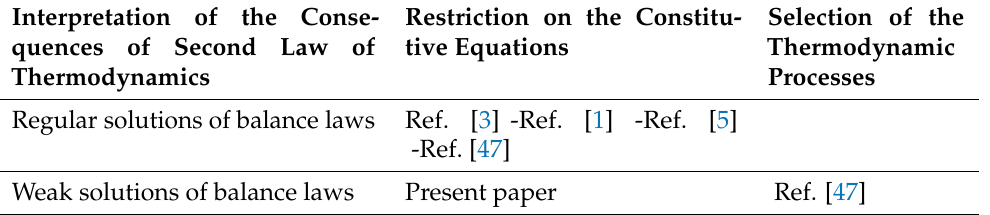
Table 3. Different Interpretations of the constraints imposed by the second law of